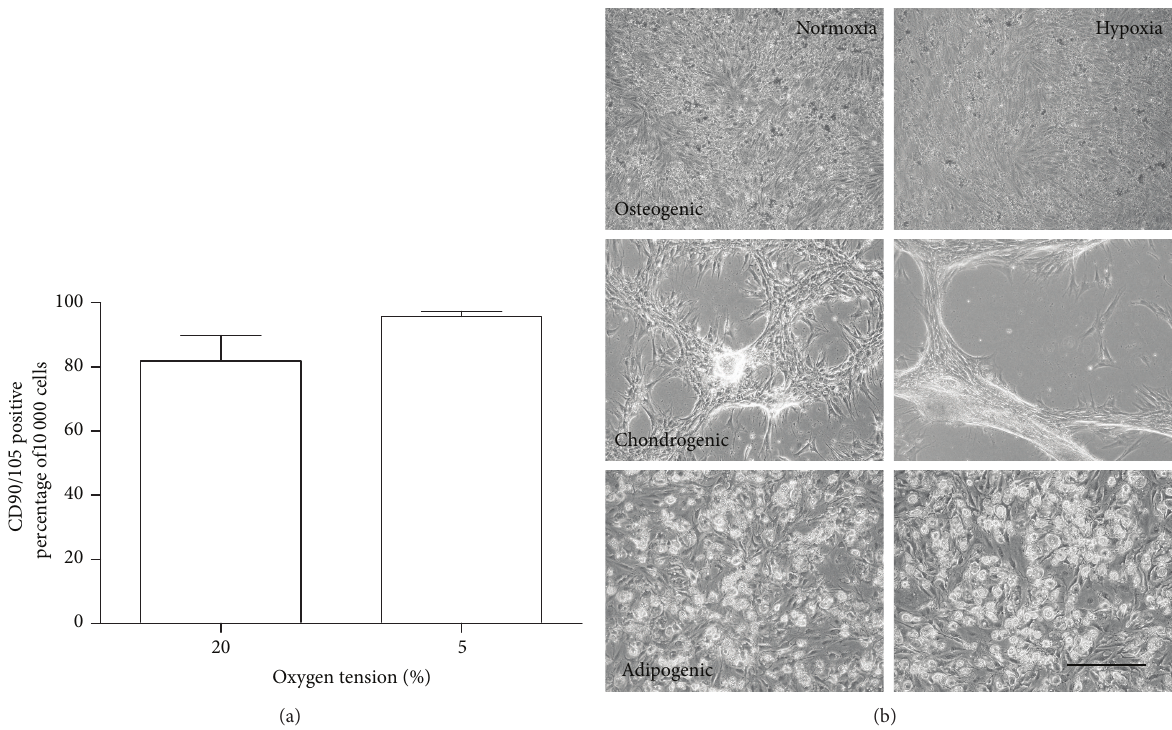
Figure 1: (a) Flow cytometry result of CD90 and CD105 expression in human primary MSCs ( 𝑛 = 6 ) both normoxia and hypoxia. Results are expressed as mean % of positive cells in the whole population. (b) Multidifferentiation assay for osteogenic (alizarin red), chondrogenic (alcian blue), and adipogenic (oil red O) staining of MSC cultures in both normoxia and hypoxia at day 21 (scale bar 200nm, 𝑛 = 4